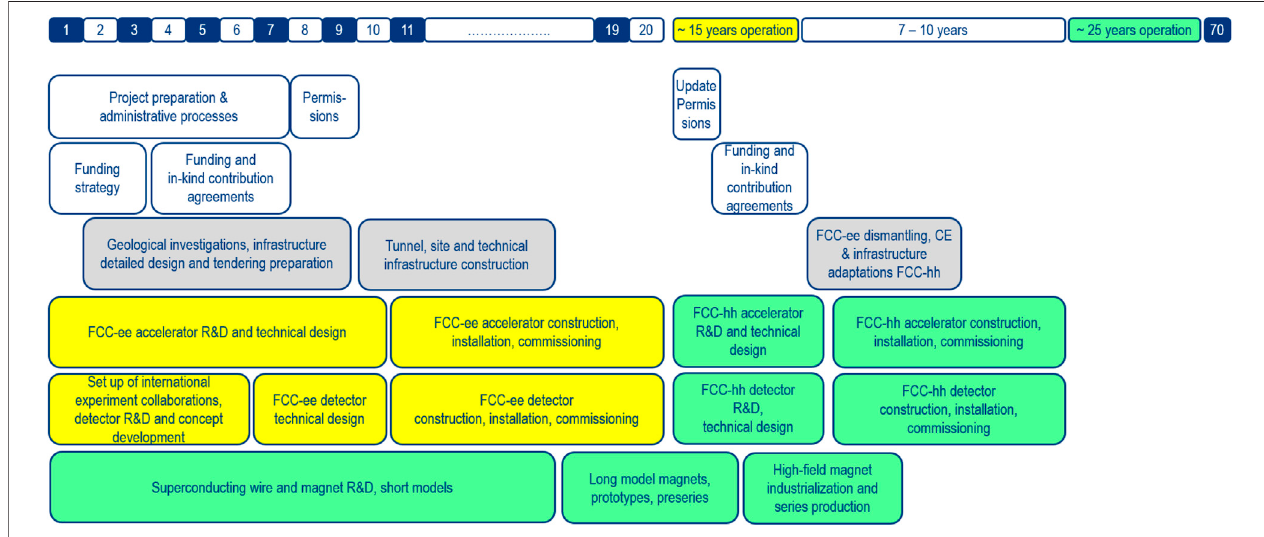
FIGURE 1 | Technical schedule of the FCC integrated project with year 1 equal to 2021 (a similar schedule was presented in Ref. [3]).